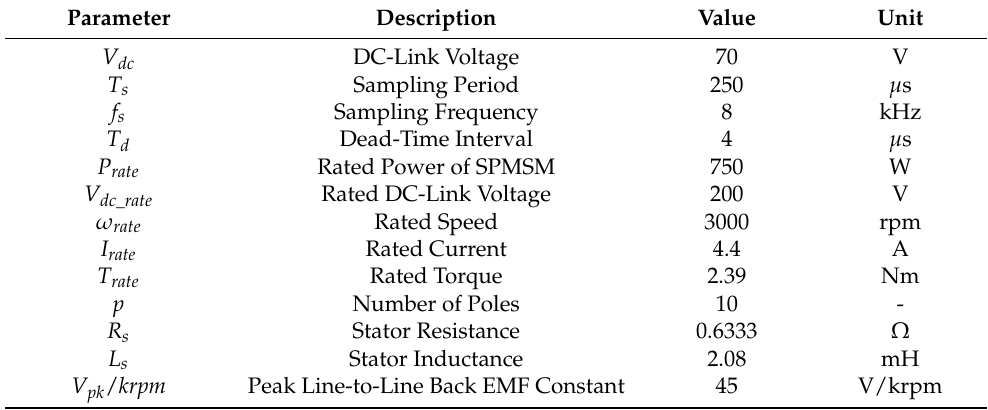
Table 2. Simulation parameters and operating